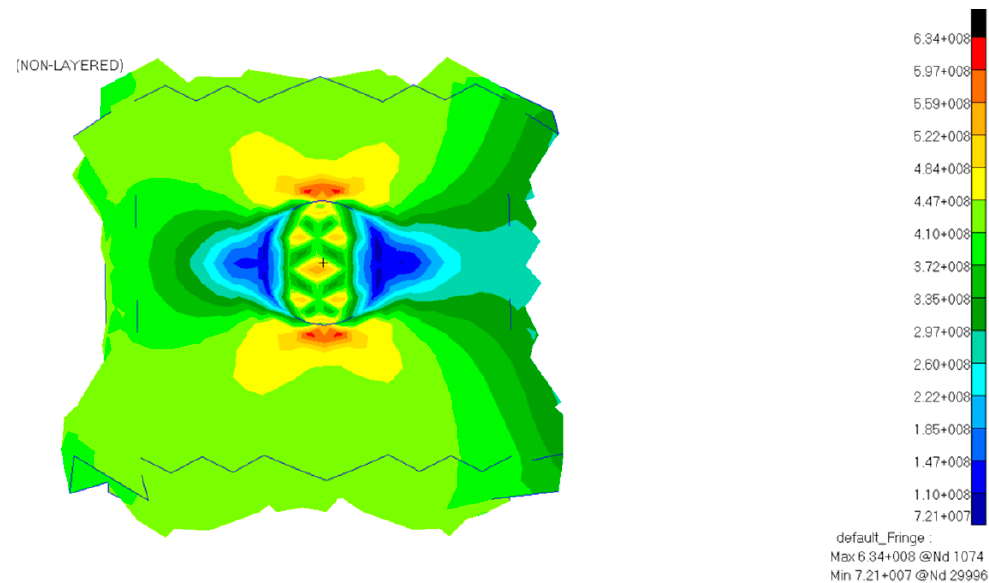
Figure 16. Von Mises illustration of the ( a ) cube-cell cross-section view, ( b ) cube-cell quarter view, ( c ) filled microcapsule, and ( d ) base cube-cell with an empty microcapsule.